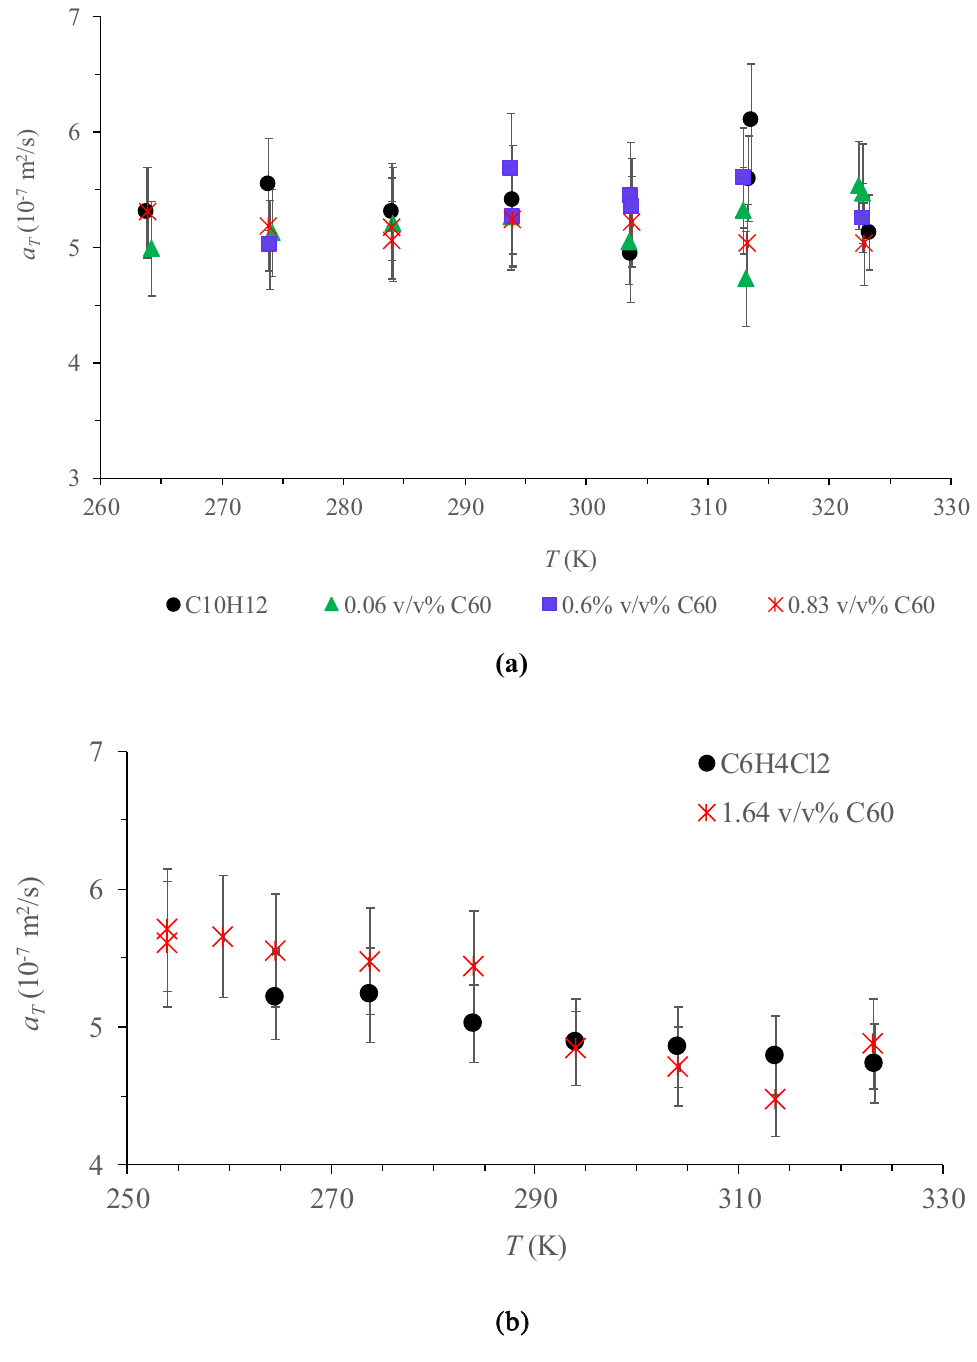
Figure 4. Measured a T of C 60 NFs together with the corresponding base liquids C 10 H 12 ( a ) and in C 6 H 4 Cl 2 ( b ) as a function of temperature ( T ). Microsoft Excel 2016 was used to generate these